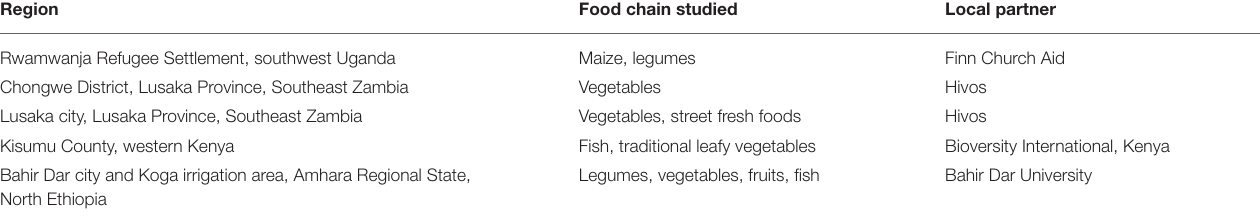
TABLE 2 | Study areas and food chains investigated. Region